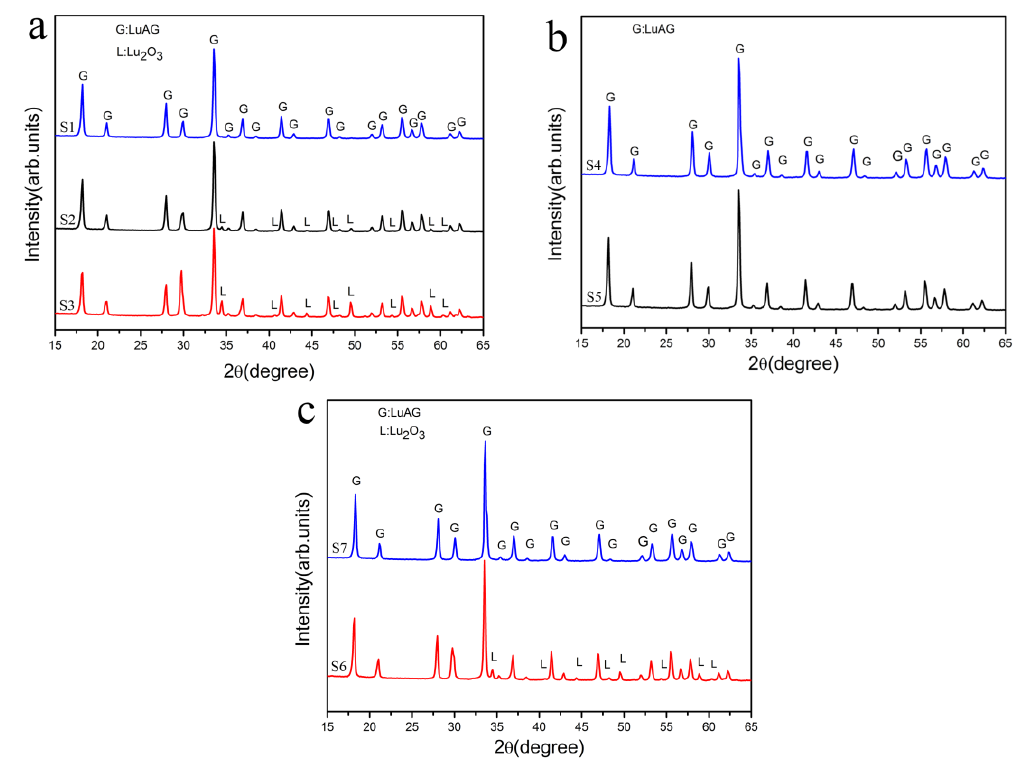
Figure 1. XRD patterns of the powders of S1–S3 ( a ); S4 and S5 ( b ); S6 and S7 ( c ) calcined at 1200 °C for 3 h.